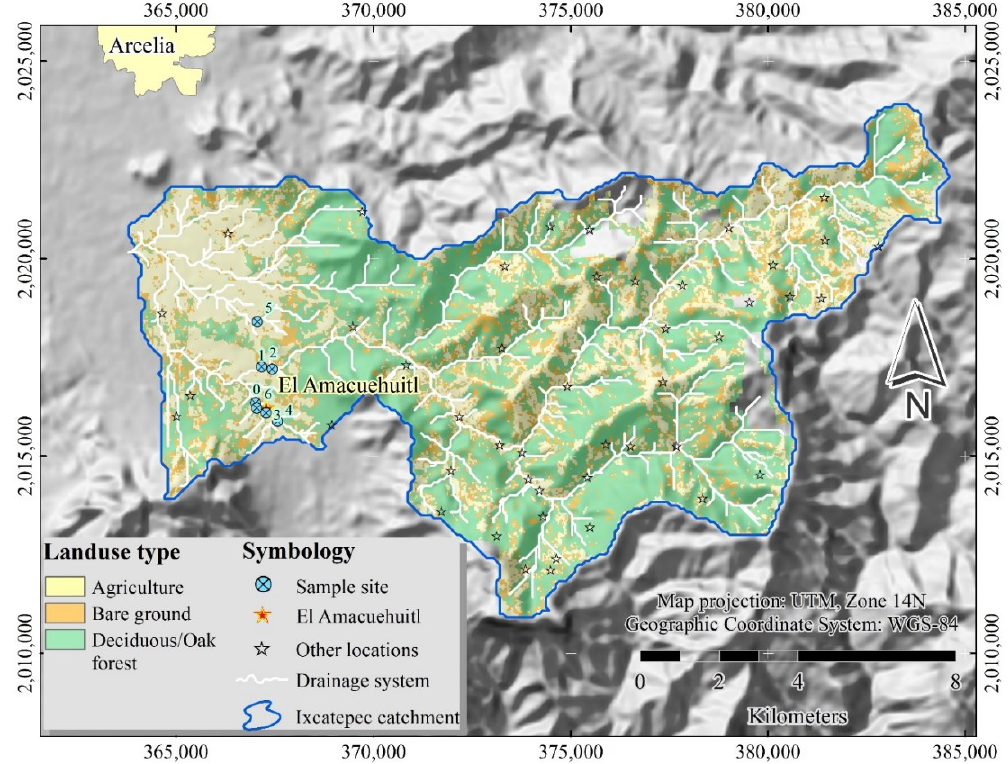
Figure 3. Land use inside the Ixcatepec catchment. Sample sites: Wells (Drinking water, 0; Brocal, 3; Azul, 4; Tello, 6); Stream water (Ixcatepec river and Arroyo, 1 and 2); pond (El Ushe, 5). Table 2. Summary of the area (km 2 ) detected from remote sensing into the Ixcatepec catchment. Land Use